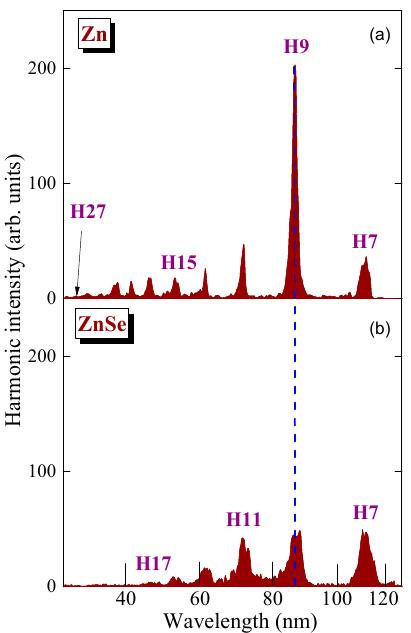
Figure 2. HHG from Zn-containing components of laser-induced plasma (LIP) using 806 nm driving pulses. Targets were ablated by 370 ps pulses. ( a ) Harmonic spectrum generated in Zn plasma using the fluence of heating F = 2 J cm − 2 . ( b ) Harmonic spectrum generated in ZnSe plasma ( F = 2.3 J cm − 2 ). Dashed line shows the position of 3d 10 4s–3d 9 4s4p transition. H7–H27 correspond to the harmonic orders.